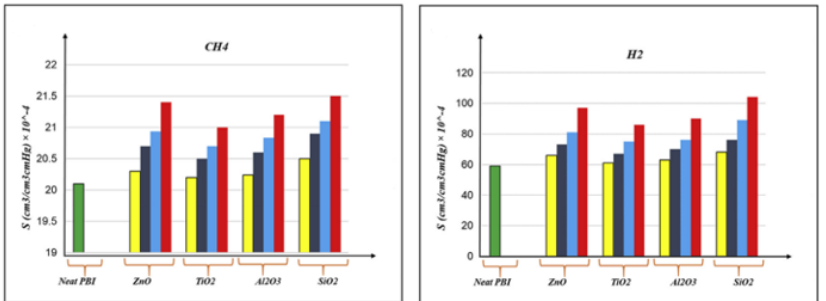
Figure 21. Solubility of H 2 and CH 4 in membranes filled with different nano-oxide materials ( P = 4 atm, T = 298 K) [53].